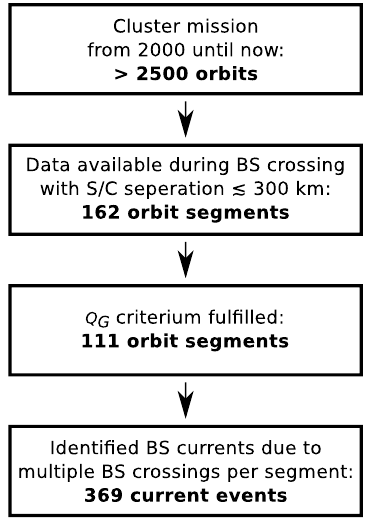
Figure 1. This sketch of the data selection process shows the shrink- ing number of suitable data sets. From over 2500 Cluster orbits only a few orbit segments match the spatial requirements and the quality criterion for our bow shock current